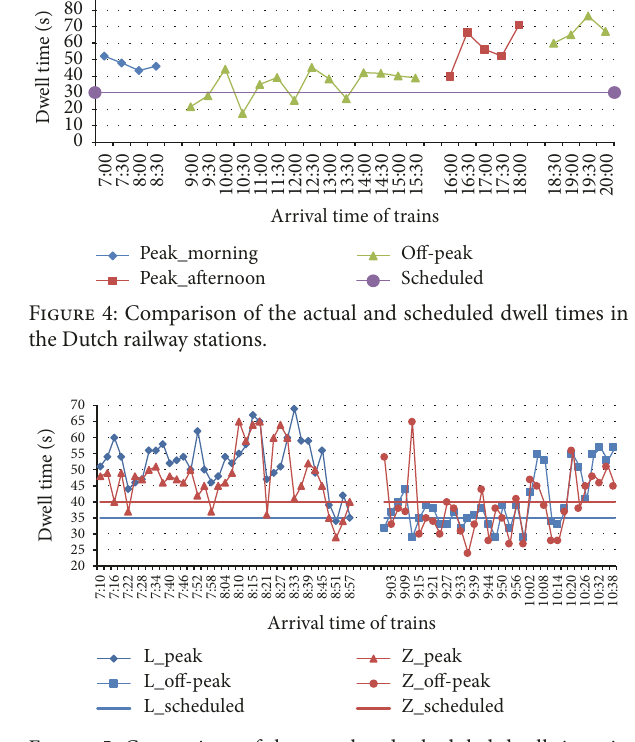
Figure 5: Comparison of the actual and scheduled dwell times in the Beijing railway